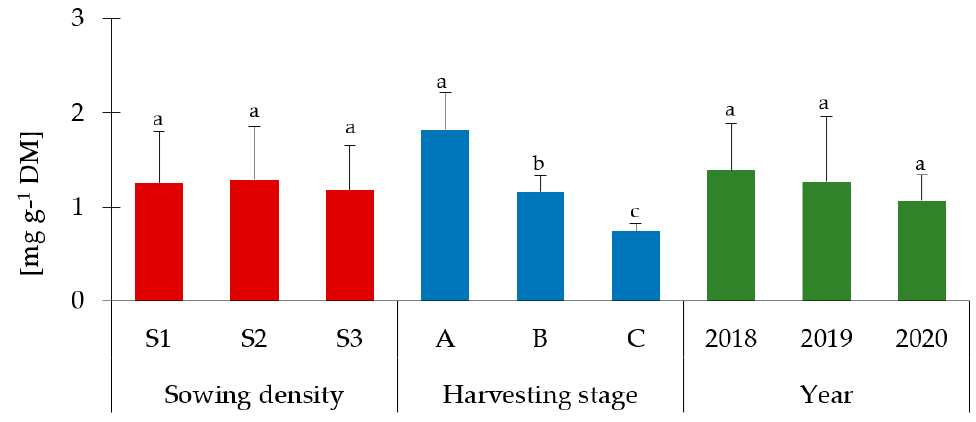
Figure 2. Coumarin content in leaves of Melilotus albus . Sowing density: S1—500 pcs · m − 2 , S2—1000 pcs · m − 2 , and S3—1500 pcs · m − 2 . A—before budding, B—budding, C—full flowering. Statistically significant differences ( p < 0.05) according to the three-way analysis of variance (ANOVA) followed by Tukey’s test are marked with different letters.